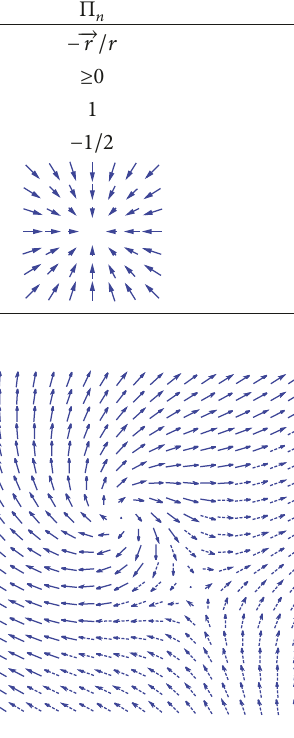
Figure 4: Configuration of Figure 3, after rotation by 𝜋/4